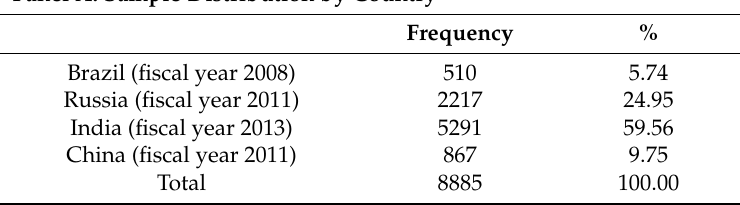
Table 2. Sample Distribution. Panel A: Sample Distribution by